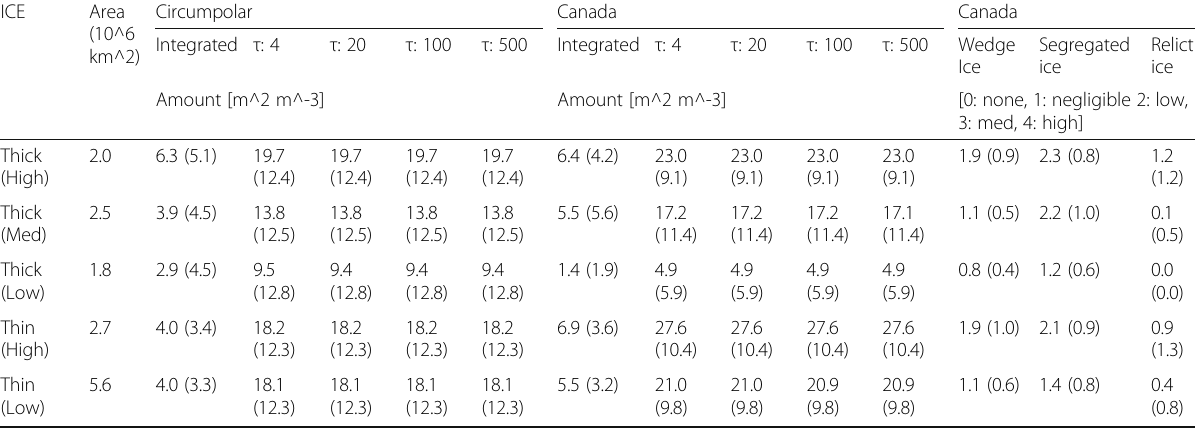
Table 3 Comparison of simulated ground ice in the circum-Arctic and Canadian region for different physiographical subsections. Averaged values in each area are shown with the standard deviation in the parentheses ICE Area Circumpolar Canada (10^6 km^2)